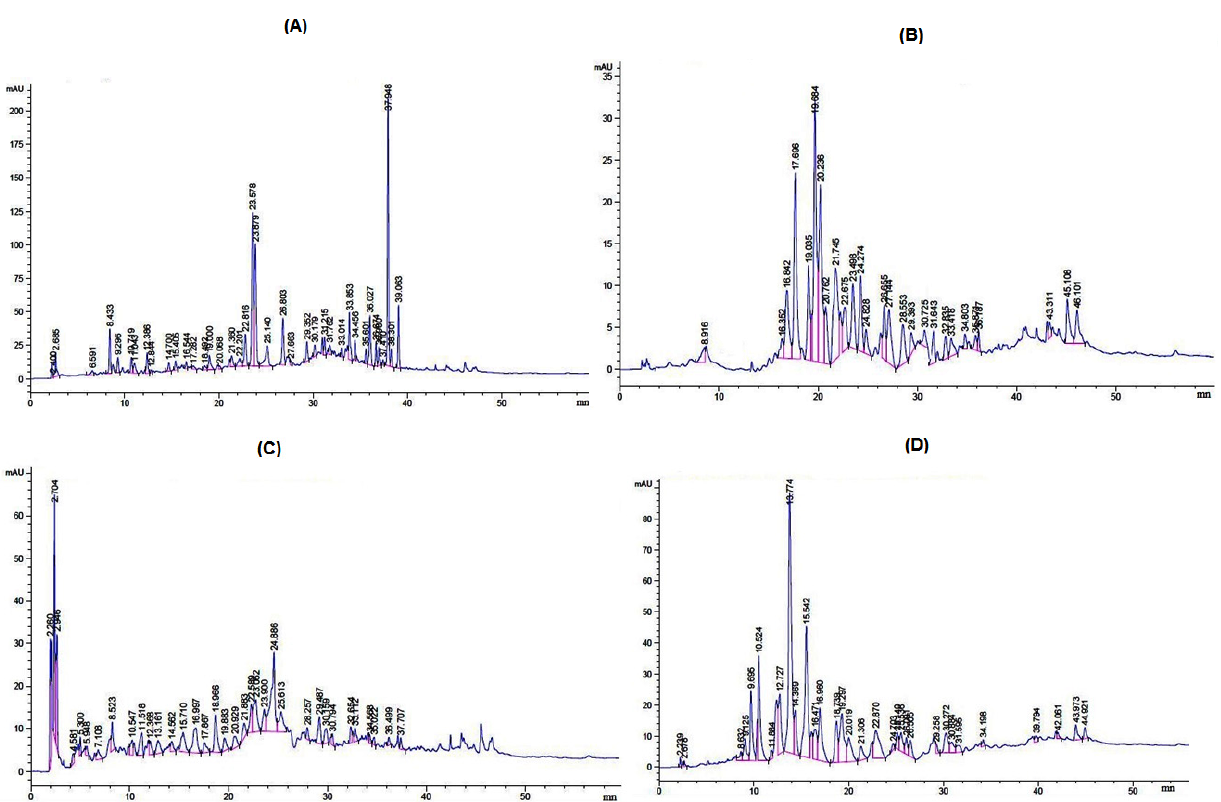
Figure 4. HPLC chromatograms of various parts of A. nitida : ( A ) leaves, ( B ) stem bark, ( C ) seeds, and ( D ) roots. Table 3. Identification and Quantification of phenolic phytochemical compounds in Alnus nitida . Part